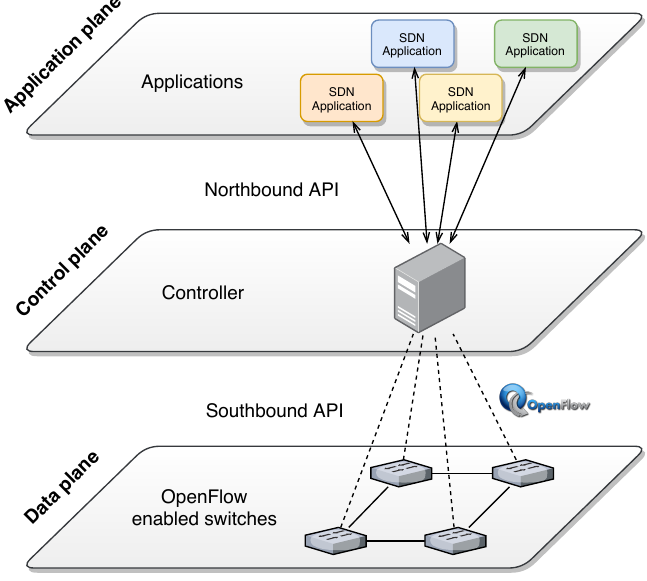
Figure 1. Software Defined Network (SDN)